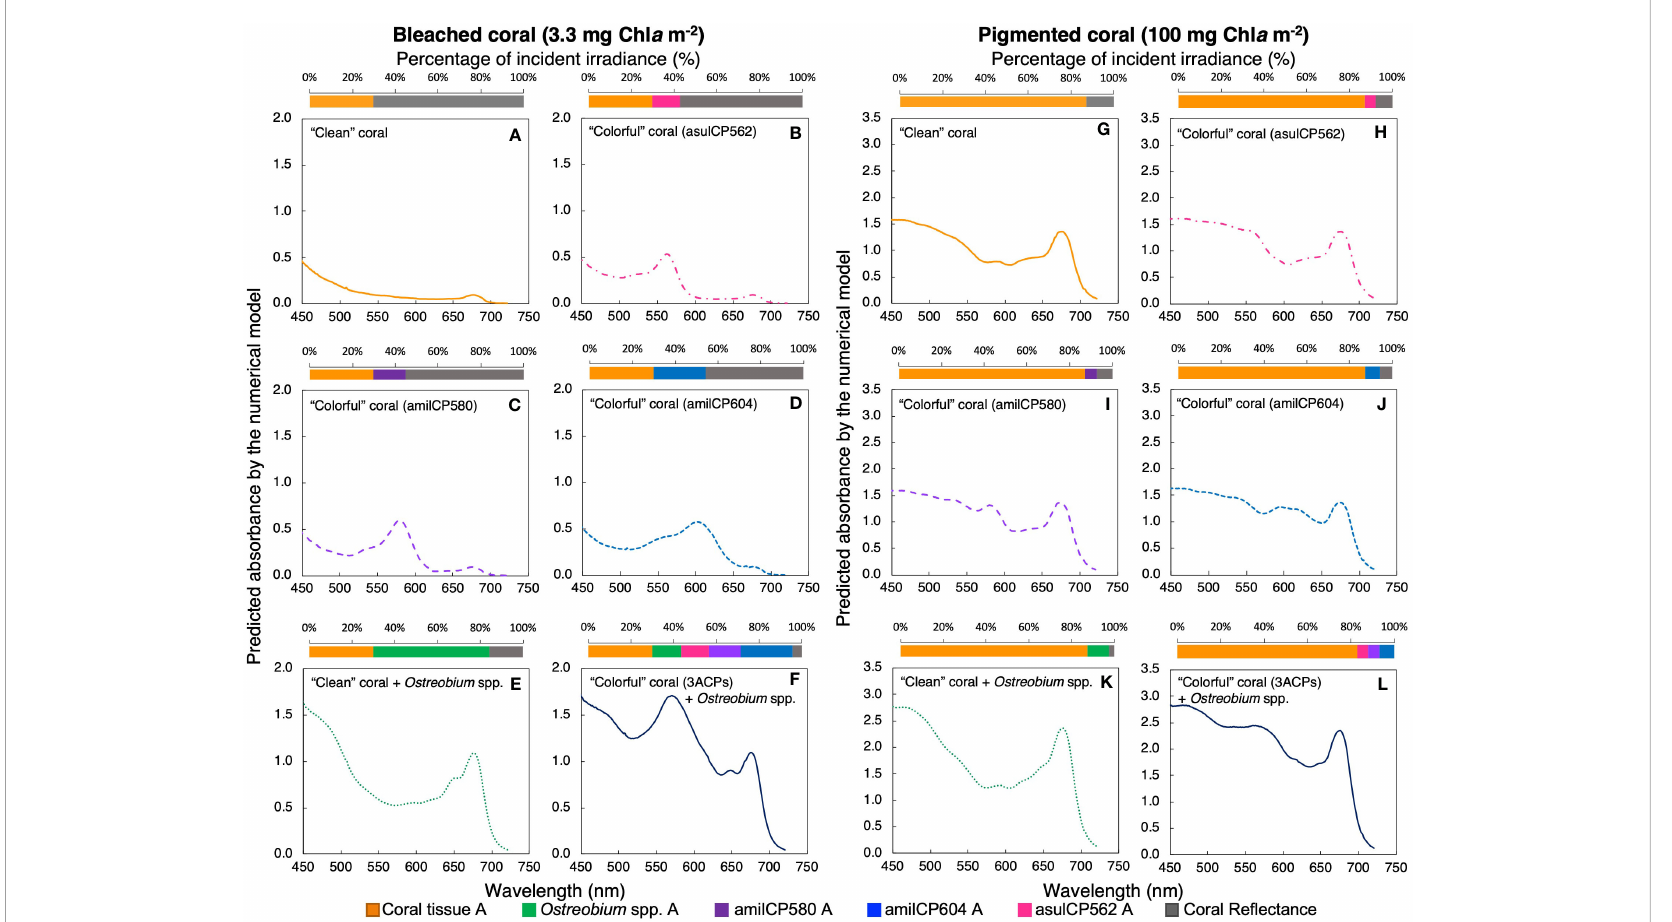
FIGURE 3 Predicted absorption spectra for a bleached ( A-F , 3.3 mg Chl a m -2 ) and a pigmented coral ( G-L , 100 mg Chl a m -2 ) under different scenarios: a coral with a white skeleton (yellow solid line, A, G ), a coral with the chromoprotein asulCP562 upregulated in its tissue (pink dotted line, B, H ), a coral with the chromoprotein amilCP580 upregulated in its tissue (purple dashed line, C, I ), a coral with the chromoprotein amilCP604 upregulated in its tissue (clear blue dotted line, D, J ), a coral with an Ostreobium bloom in the skeletal surface (green dotted line, E, K ), and a coral with the three chromoproteins upregulated in its tissue and an Ostreobium bloom in the skeletal surface (navy blue solid line, F, L ). Superior panels indicate the percentage of incident PAR utilized by each pigmented layer: coral tissue (yellow), chromoprotein asulCP562 (pink), chromoprotein amilCP580 (purple), chromoprotein amilCP604 (blue), Ostreobium spp. (green), and coral re fl ectance